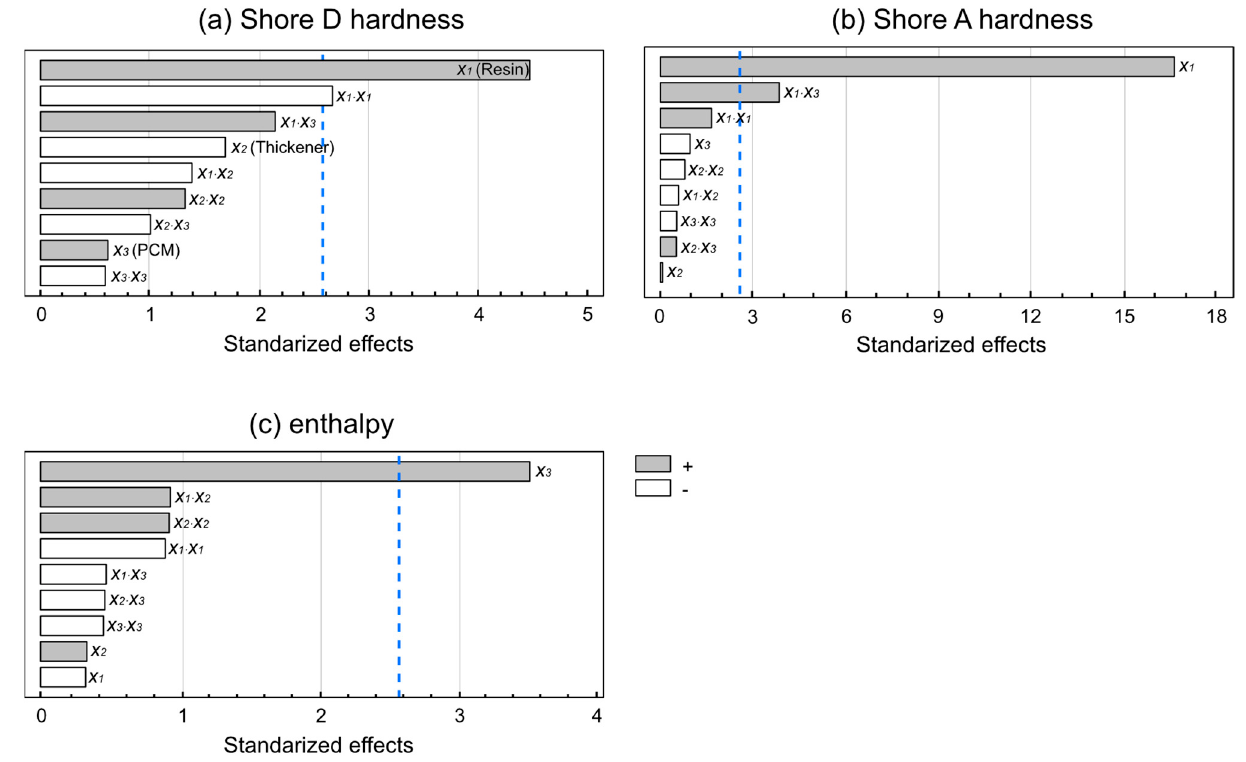
Figure 5. Pareto chart of standardized effects, showing the influence of the independent variables on the dependent variables. ( a ) Shore D hardness; ( b ) Shore A hardness; ( c ) Heat exchange. Values exceeding blue line are those significantly influencing the process.